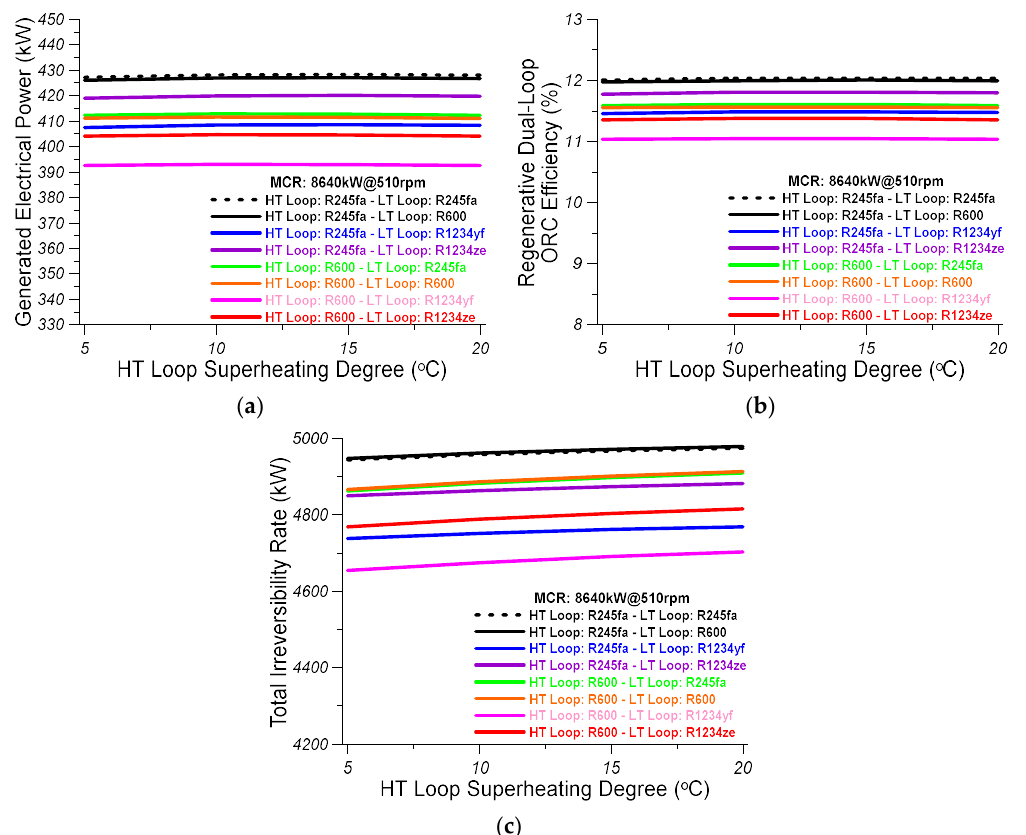
Figure 9. (a) Effect of the superheating degree of the organic medium in the HT loop on the generated electric power of the regenerative dual-loop ORC; (b) Effect of the superheating degree of the organic medium in the HT loop on the thermal efficiency of the regenerative dual-loop ORC; (c) Effect of the superheating degree of the organic medium in the HT loop on the total irreversibility rate of the regenerative dual-loop ORC. Results are given for all of the pairs of organic mediums that are examined in the present study.